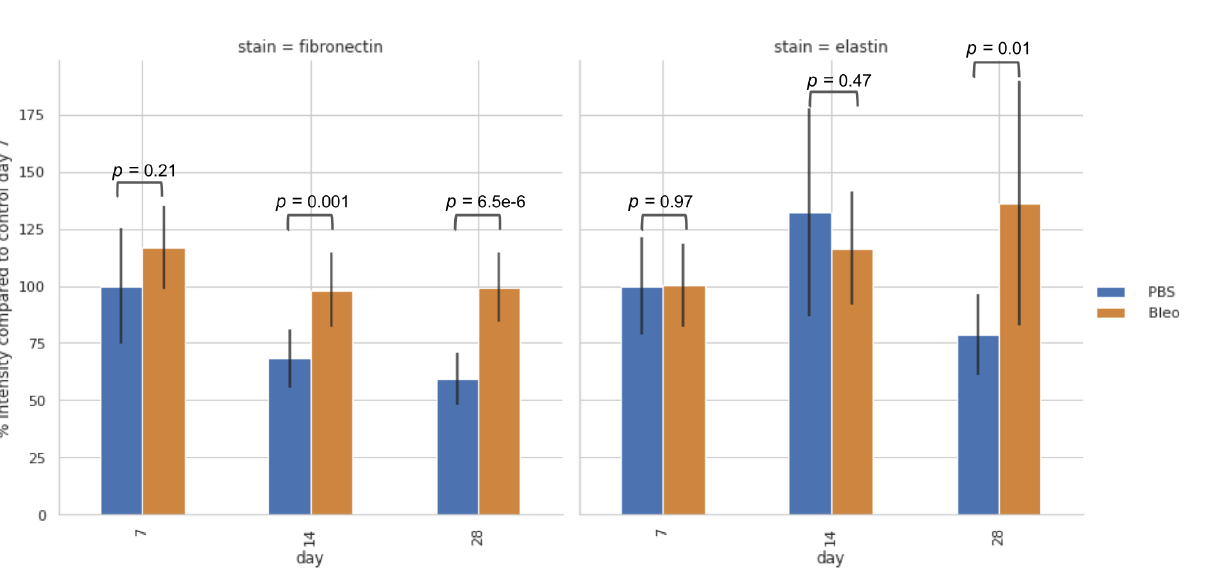
Figure 8. Evolution of percentage of fluorescence signal in relation to PBS instilled samples at day 7 for fibronectin ( left ) and elastin ( right ). Data are mean ± SD ( n = 3 for control and n = 7 for